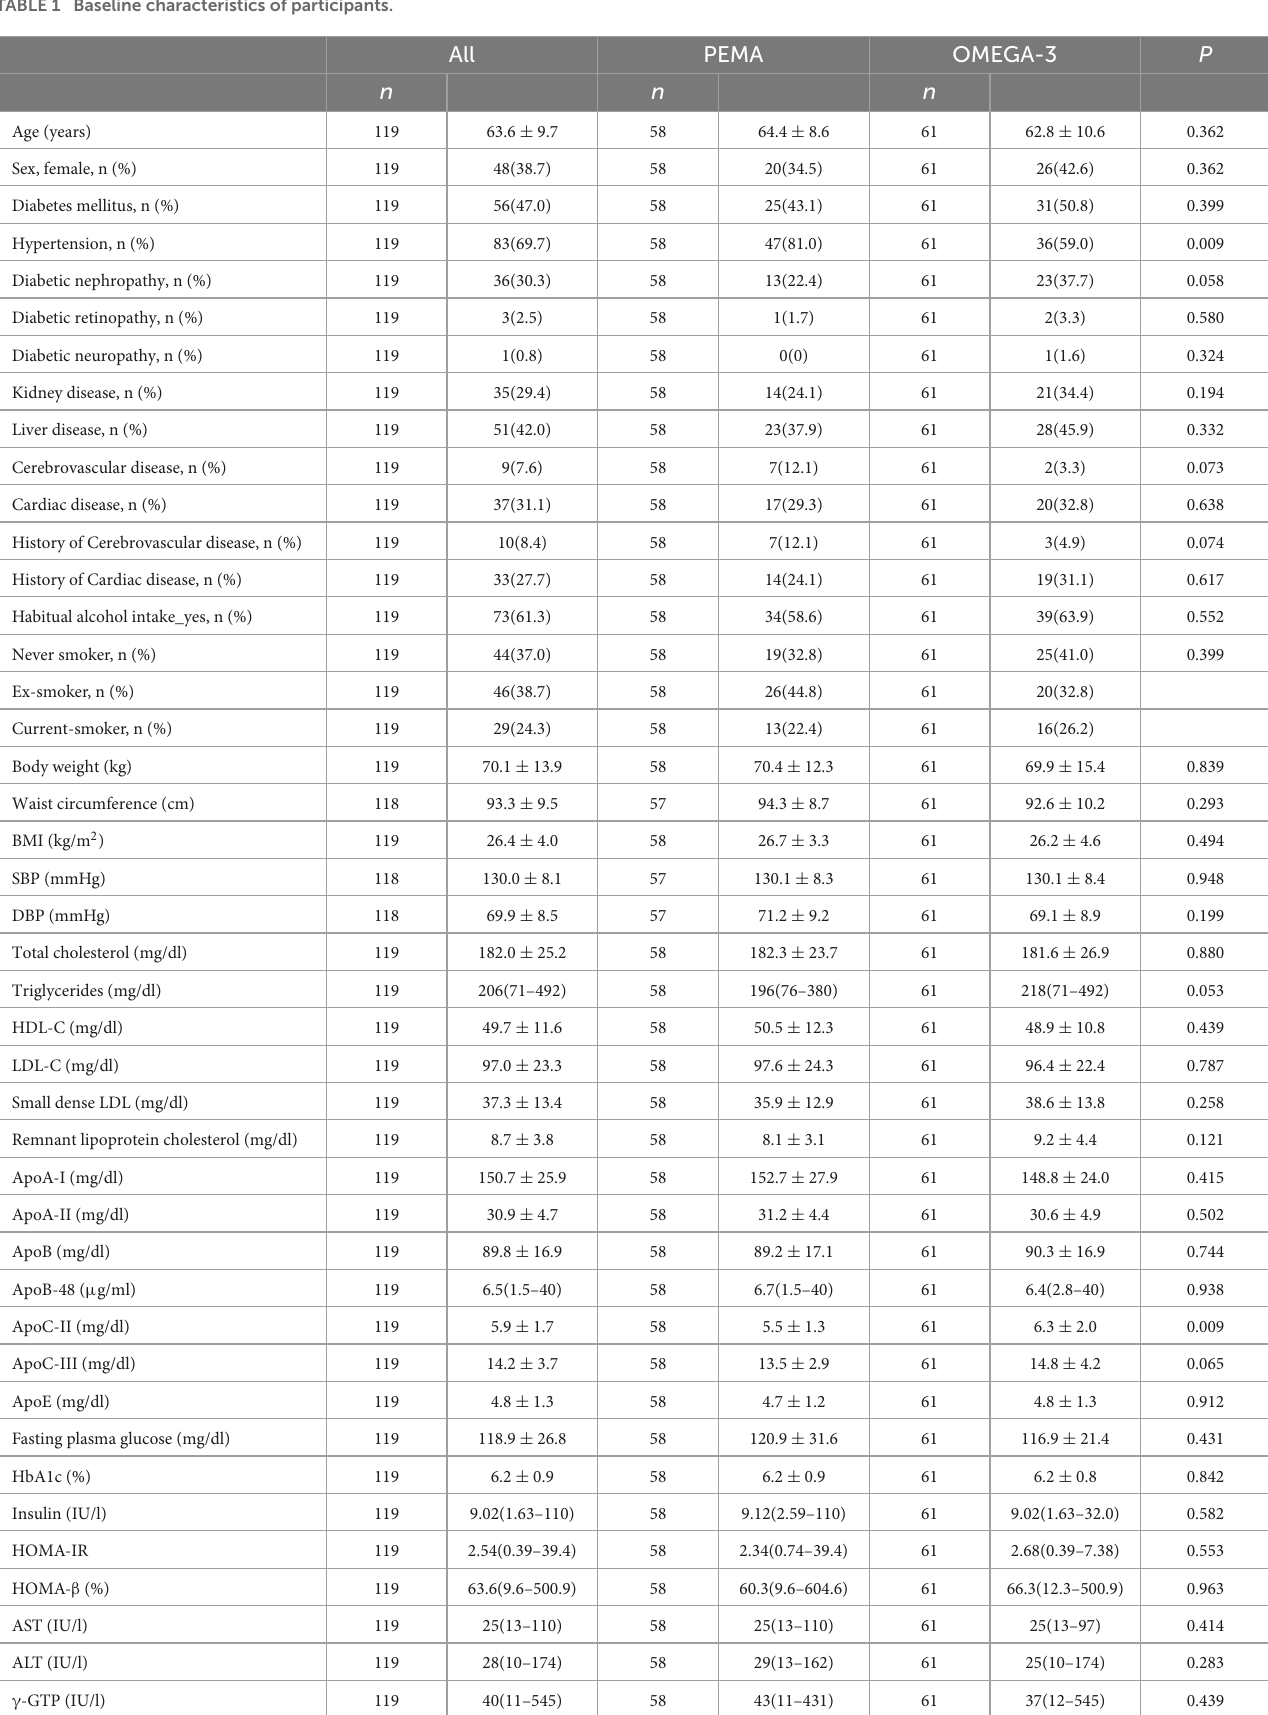
TABLE 1 Baseline characteristics of